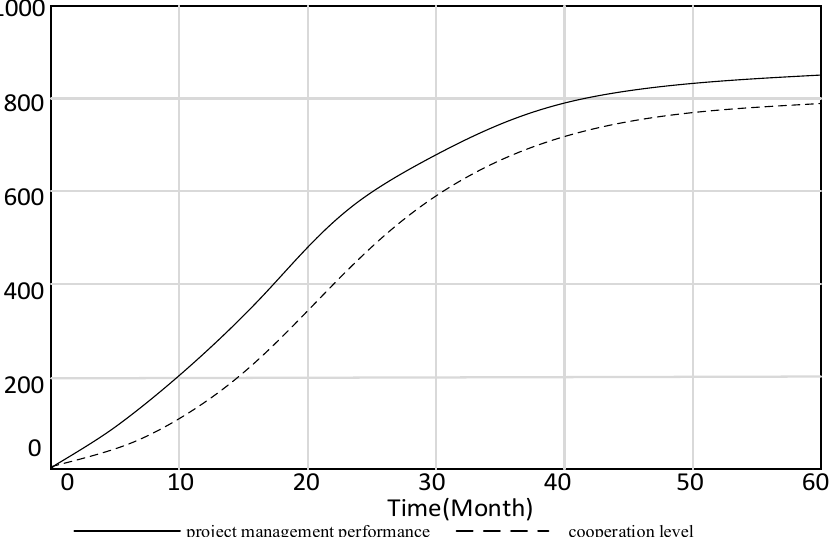
Figure 5. Dynamic evolution curve of project management performance and cooperation level.